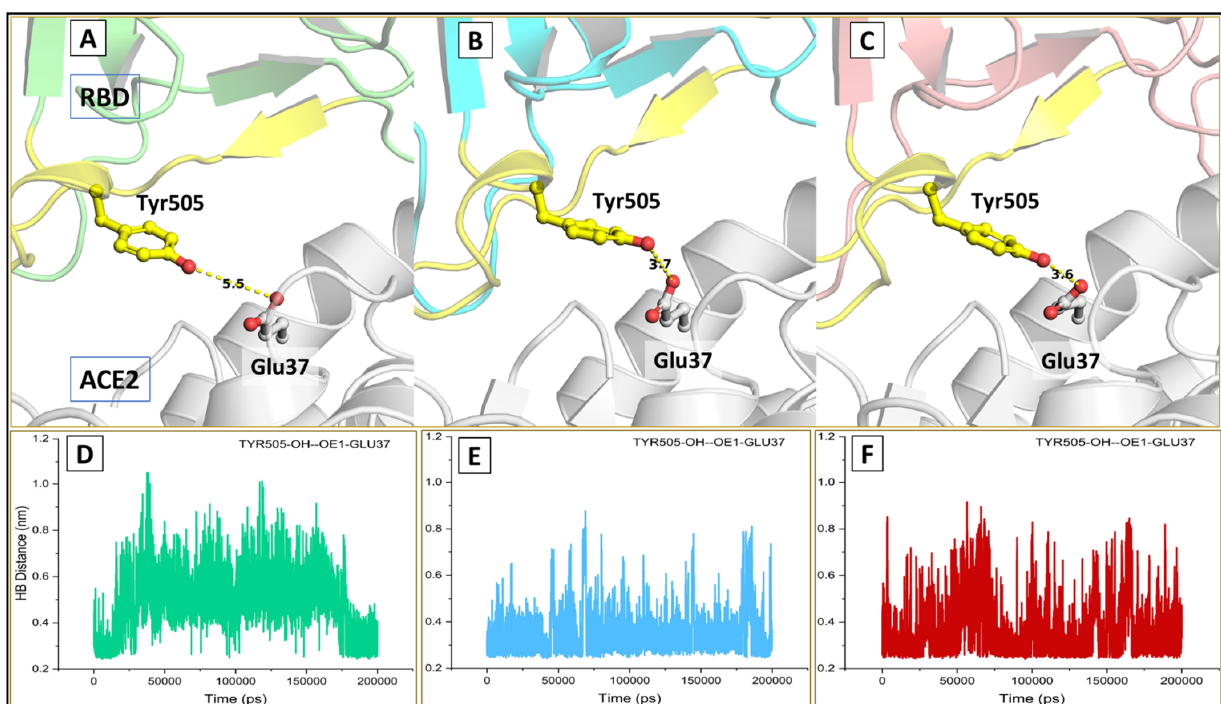
Figure 10. Intermolecular hydrogen bonds at the binding interface ( A – C ) showing hydrogen-bonded interactions at position 505 in the wild (green), kappa (cyan) and delta (red) respectively; ( D – F ) plot for hydrogen bond distance.